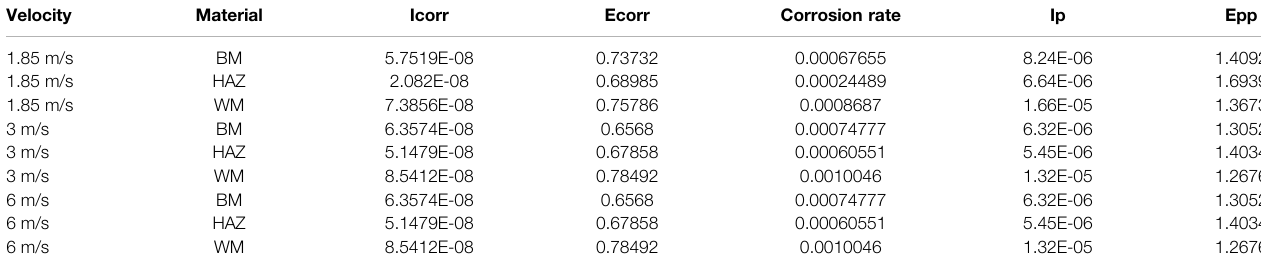
TABLE 3 | Fitting data of polarization curves of the three zones after 12 h of scouring by 1.85, 3, and 6 m/s fl ow rates of seawater. Velocity Material